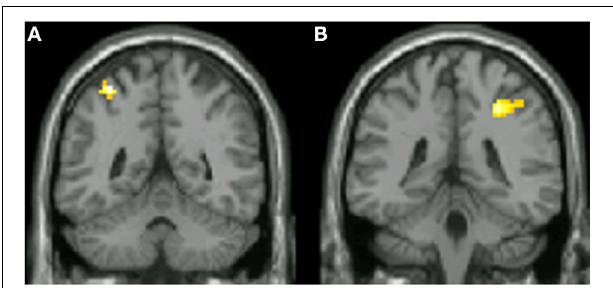
FIGURE 5 | Coronal slices displaying functional data derived from 16 subjects superimposed onto the canonical brain. Areas in which significant concept associated activity was found are shown, based on the contrast color concept > color non-concept ( p < 0 . 001 uncorrected). Inferior parietal areas are shown in both the left ( A ; MNI Y = − 50) and right ( B ; MNI Y = − 37) hemispheres.